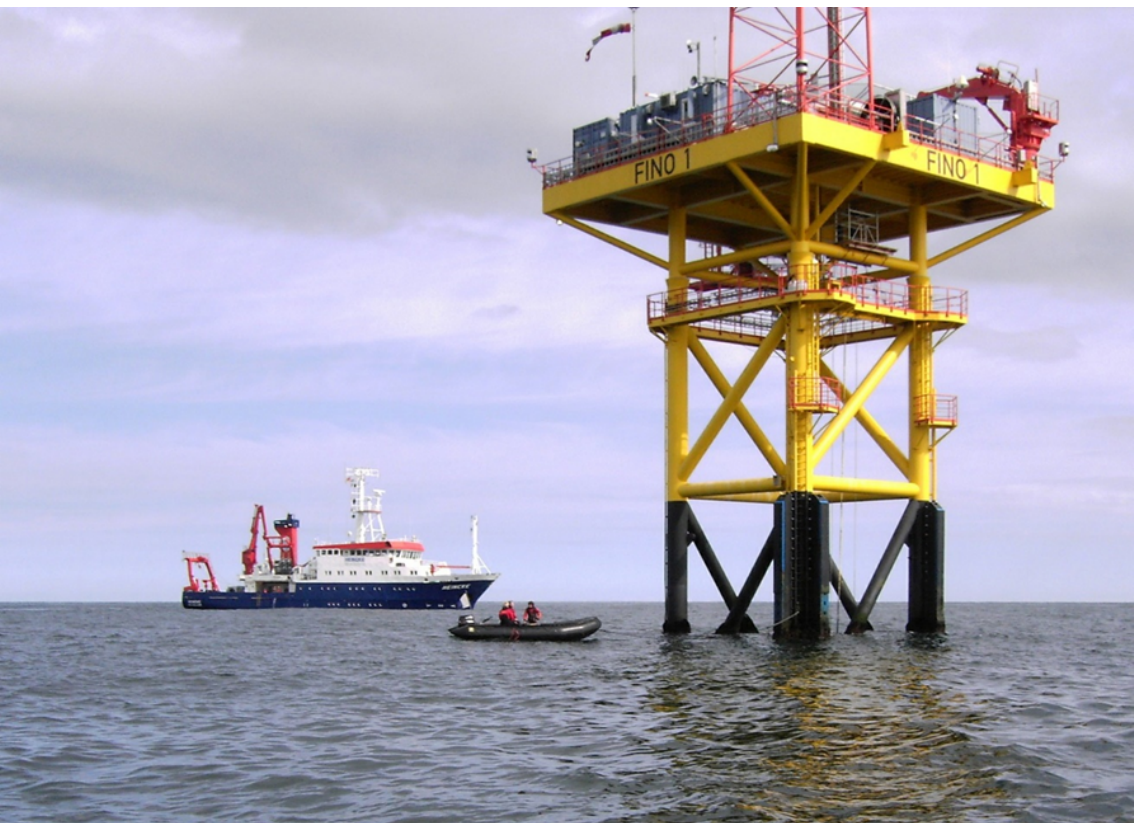
Figure 2: Heincke operating at the research platform FINO1, German Bight, North Sea Photo: AWI / AG